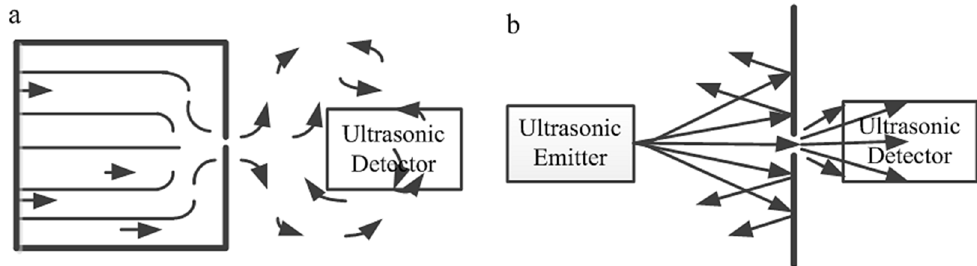
Figure 1. Ultrasonic-based detection methods for: ( a ) sealed part; ( b ) unclosed part.